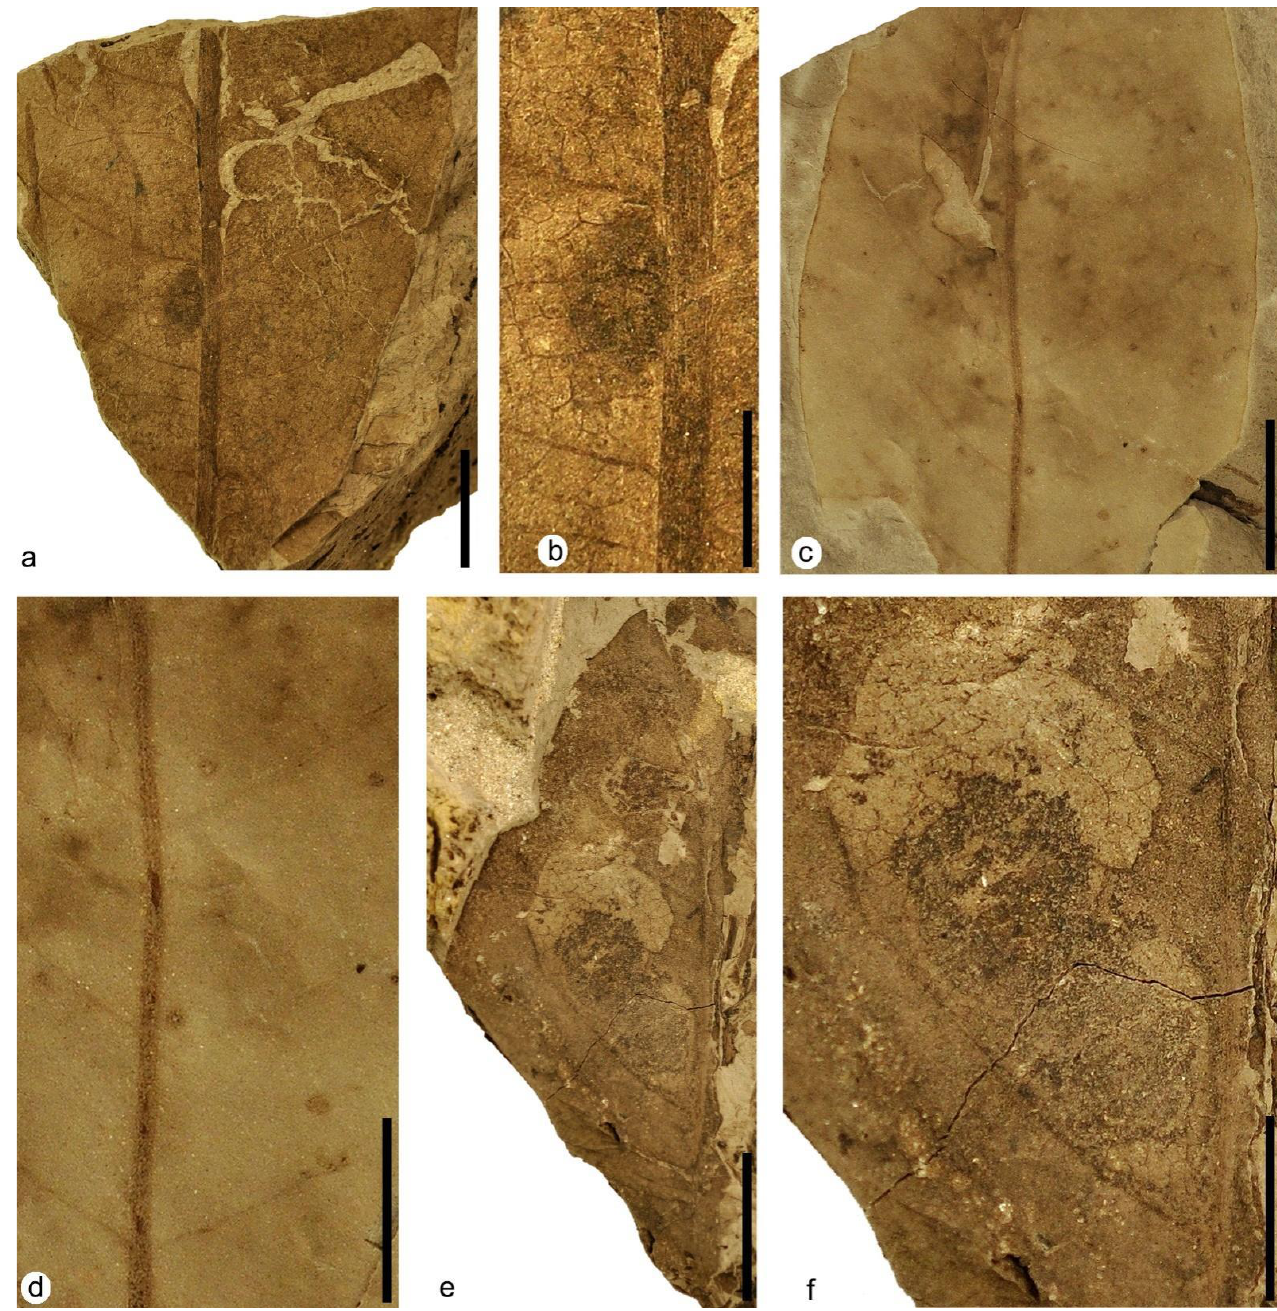
Figure 7. Plant–insect interactions on leaves of the terrestrial Angiosperm Type 1. ( a ) MAP-8367, fragment of leaf with surface feeding DT29. ( b ) Detail of surface feeding DT29 in photo ( a ). ( c ) Detail of the central area of the leaf in Figure 6df corresponding to MAP-8364 with hole feeding DT05, margin feeding DT14 and piercing and sucking DT46. ( d ) Detail of the central part of photo ( c ) with piercing and sucking DT46. ( e ) MAP-8368, a middle apical part of a leaf fragment with mining DT35 showing two complex mines. ( f ) Detail of the lower complex mine of photo ( e ) with mining DT35. Scale bars: ( a , c , d , f ) = 1 cm; ( b ) = 5 mm; ( e ) = 2 cm. DT43: specimens MAP-8369 (Figure 8a – c) and MAP-8370 (Figure 8d – f). Several serpentine-shaped mines spread over the entire surface of the leaves. The mines present different shapes, from slightly curved to highly sinuous to serpentine paths presenting DT13: specimen MAP-8363 (Figure 6c). Excision of leaf apex, including primary vein. thick, densely packed solid frass along the margins but a lower amount of frass in the The leaf has several feeding excisions along its margin, including the apex. At least six excisions are distinguishable. At the lower left margin, there is an excision